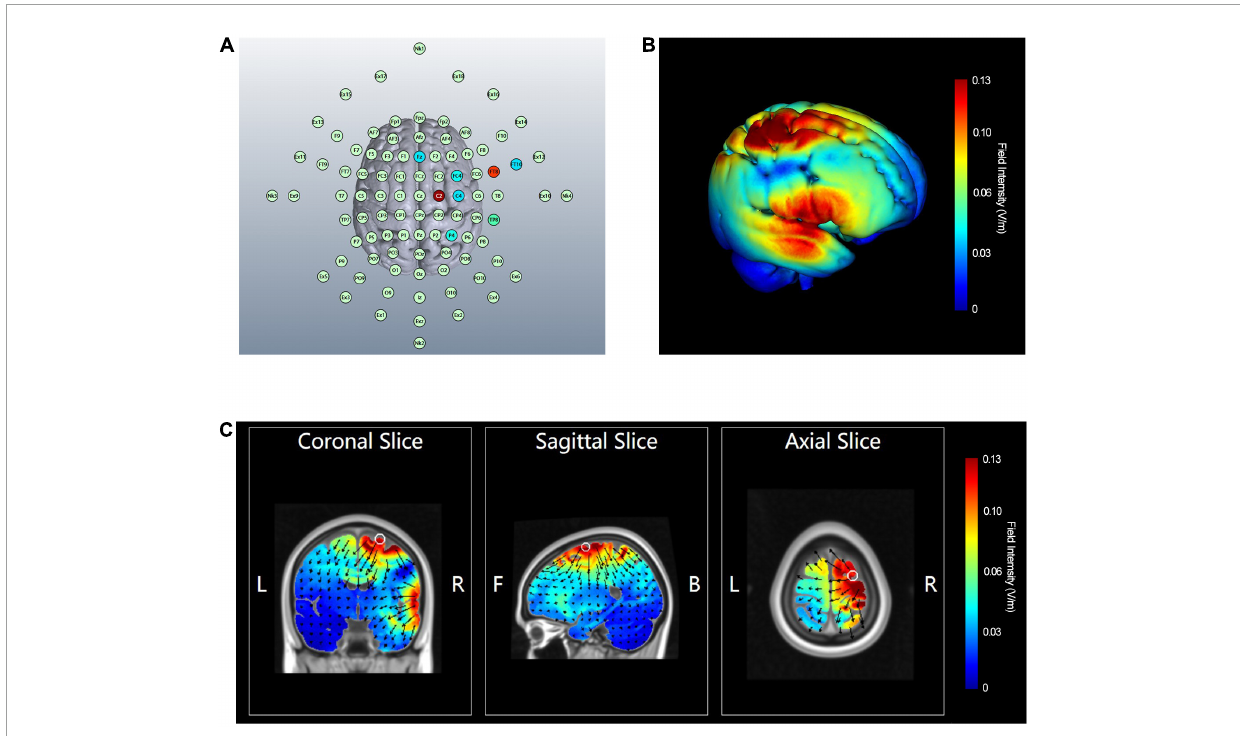
FIGURE2 Electrode configuration and computational neurostimulation modeling of multitarget HD-tDCS. (A) Electrodes configuration. (B) A 3D view of the simulated electric field. (C) The section view of simulated electric field and current direction. The color bar represents the field intensity. The arrow points in the direction of the current flow, and the length indicates the current flow intensity. L, left; R, right; F, front; B,